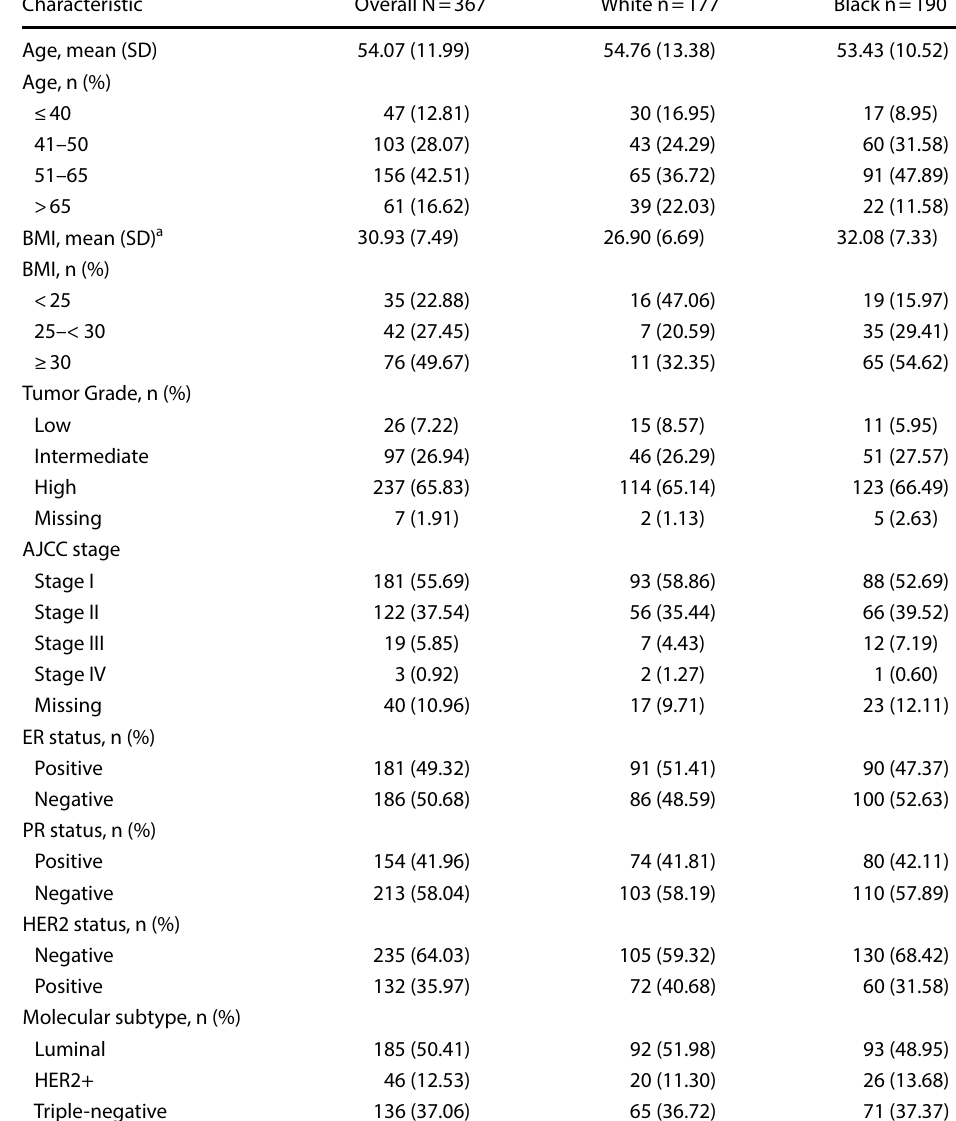
Table 1 Characteristics of the study